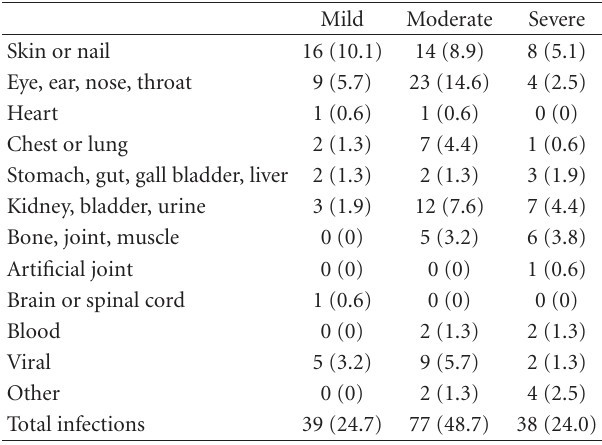
Table 4: Self-reported infections and their severity ∗ within the six months prior to commencing bDMARDs ( n =